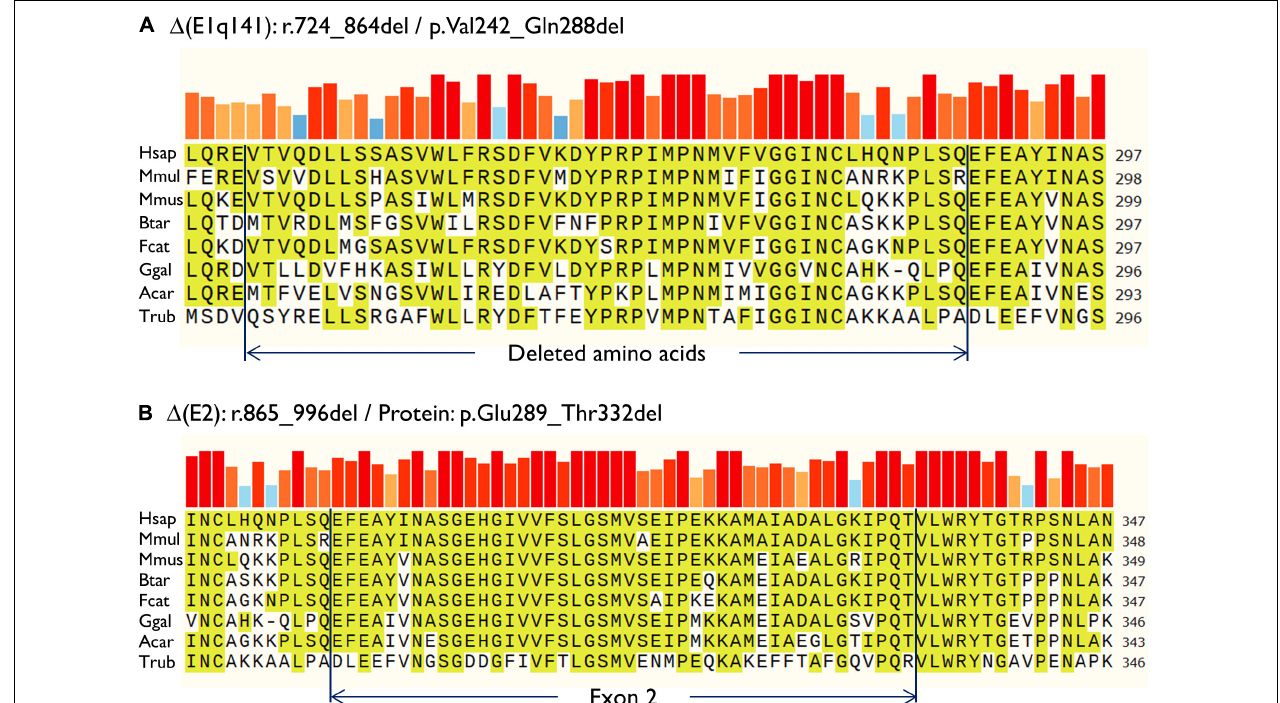
FIGURE 3 | Amino acid conservation of the deleted sequences of the anomalous transcripts (A) (cid:49) (E1q141) and (B) (cid:49) (E2). Protein sequences were aligned with the Align tool of the Uniprot database (https://www.uniprot.org/align/). The alignment file was visualized with SnapGene Viewer version 4.3.11. The conserved residues are highlighted and the colored bars above the protein sequence show the degree of conservation where a red bar indicates the maximum level of conservation (100%). Organisms: Hsap, Homo sapiens; Mmul, macaque ( Macaca mulatta ); Mmus, mouse ( Mus musculus ); Btar, cow ( Bos Taurus ); Fcat, cat ( Felis catus ); Ggal, chicken ( Gallus gallus ); Acar, Anole lizard ( Anolis carolinensis ); Trub, fugu ( Takifugu rubripes